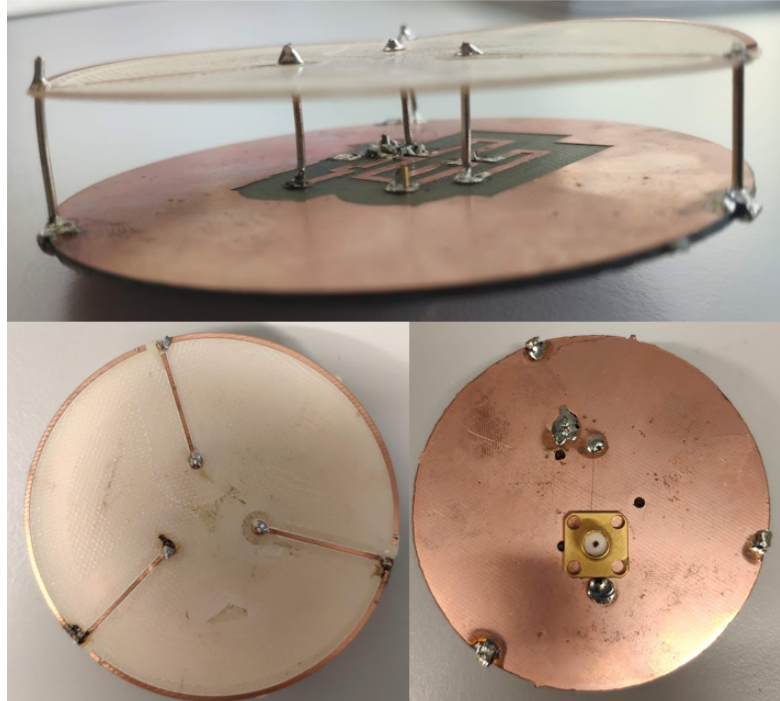
Figure 8. Picture of the